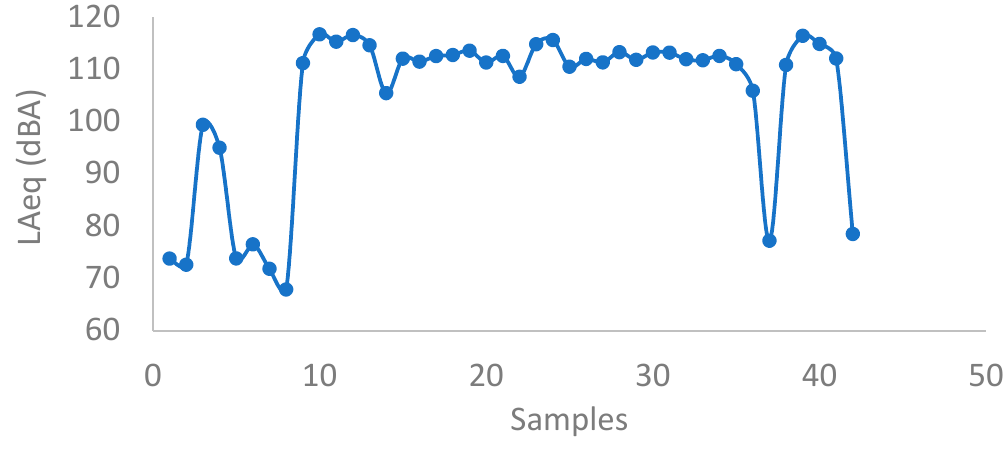
Figure 4. Evolution of the bell tower in dB(A).